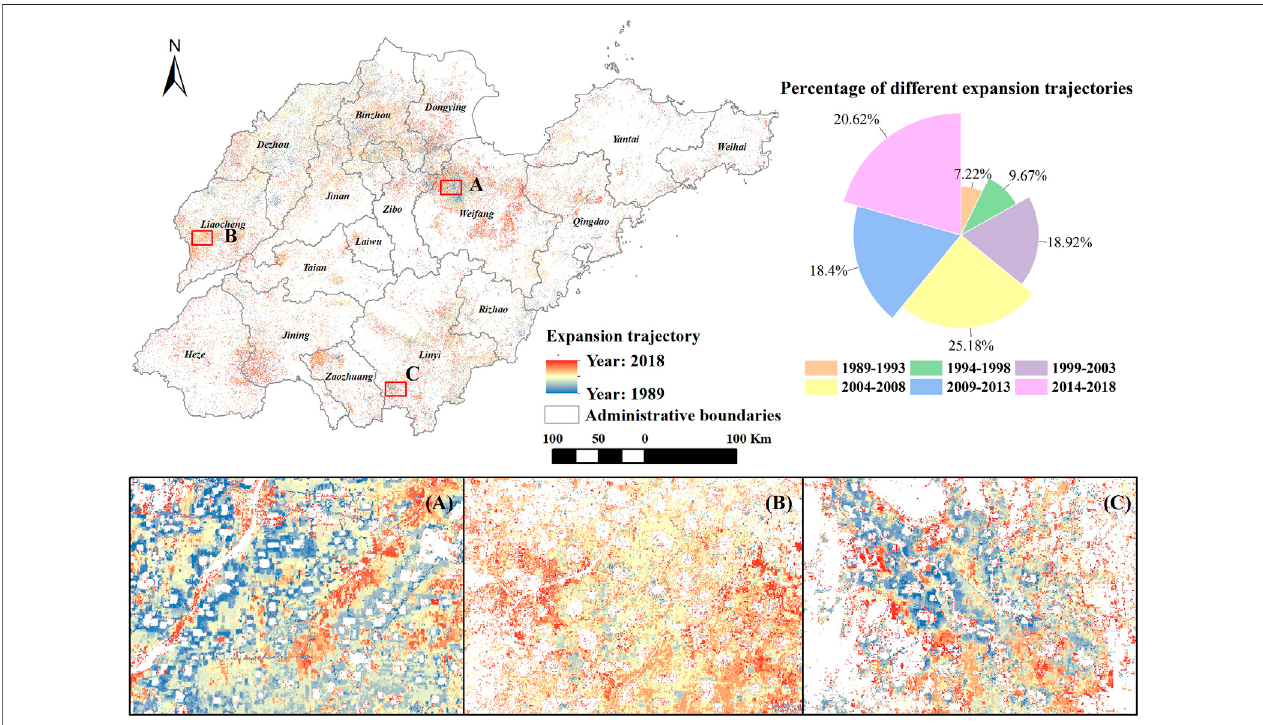
FIGURE 6 | The expansion trajectory patterns of GCL: (A) enlarge area A, (B) enlarge area B, and (C) enlarge area C.